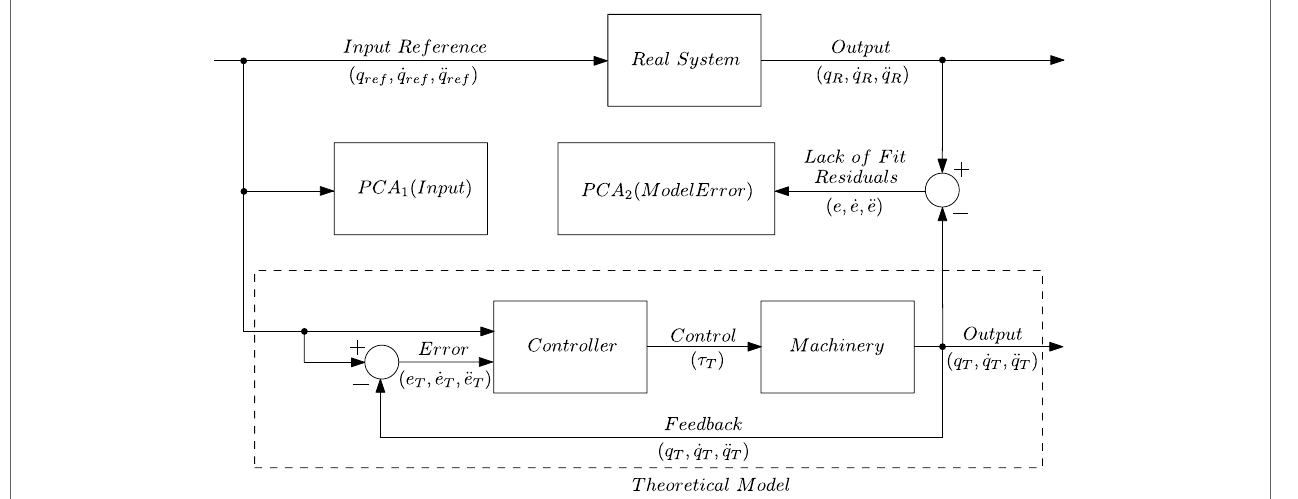
FIGURE 3 | Quality control: PCA of the input and corresponding lack-of-fit residuals.